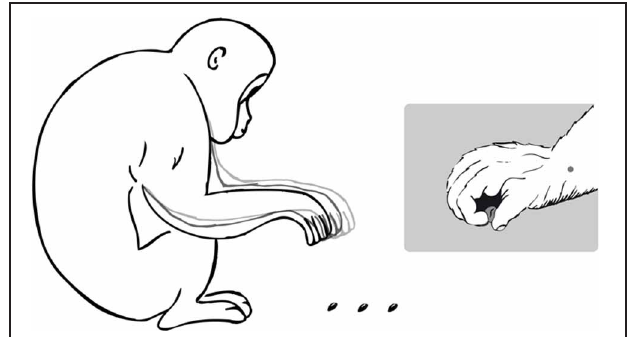
FIGURE 1 | Left Panel: schematic drawing representing the posture adopted by the animal during the reach-to-grasp movement. Overlays indicate the movement performed at three different distances. Right Panel : positioning of the marker upon the wrist for the purpose of digitalization. Markers were located ( post-hoc ) on the wrist, and the distal phalanx of the thumb and index finger. A precision grip involving the tip of the forefinger and thumb to hold small objects is